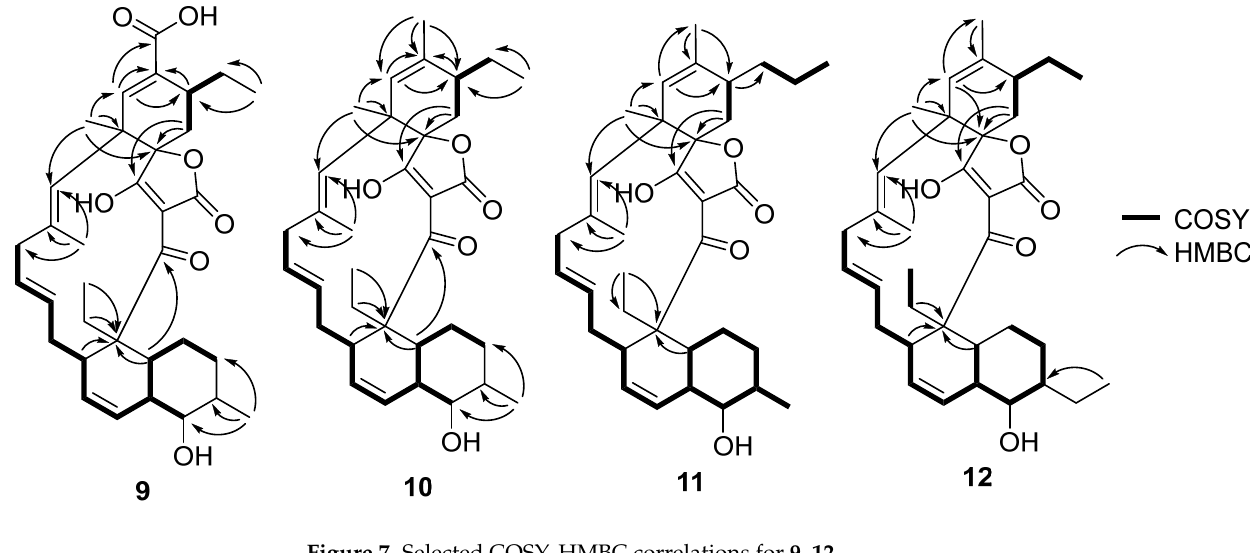
Figure 7. Selected COSY, HMBC correlations for 9 – 12 .